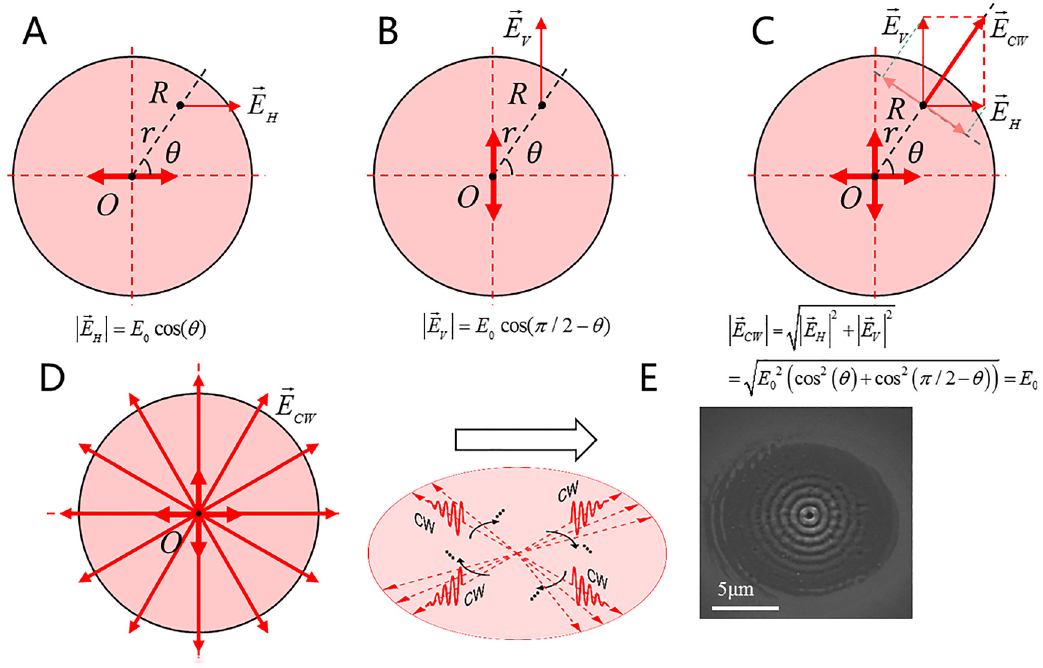
Figure 7: (A) Case of horizontally polarized femtosecond laser single-spot irradiation. (B) Case of vertically polarized femtosecond laser single-spot irradiation. (C) Case of single-spot irradiation of OP pulses. (D) Spatial distribution of cylindrical wave stimulated with OP pulses through single-spot irradiation. (E) SEM image of concentric ring